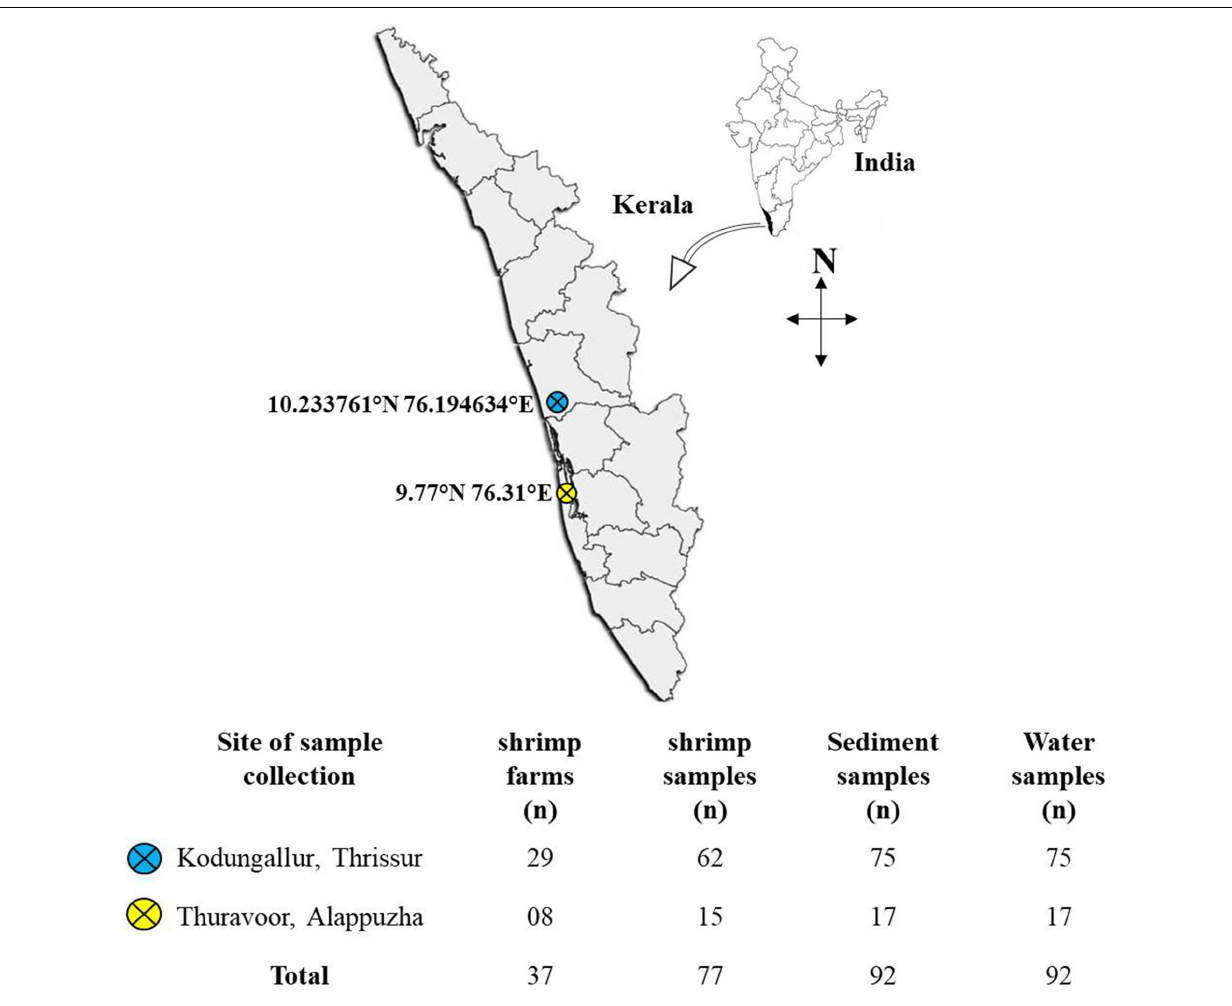
FIGURE 1 | Map of the study region showing the locations of sampling sites. Below the map is a table giving information on the number of farms surveyed and the samples